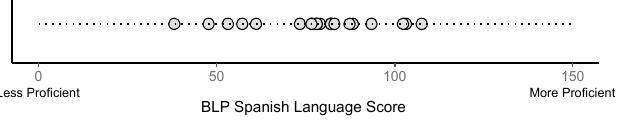
Figure 1. BLP Spanish language score by participant.